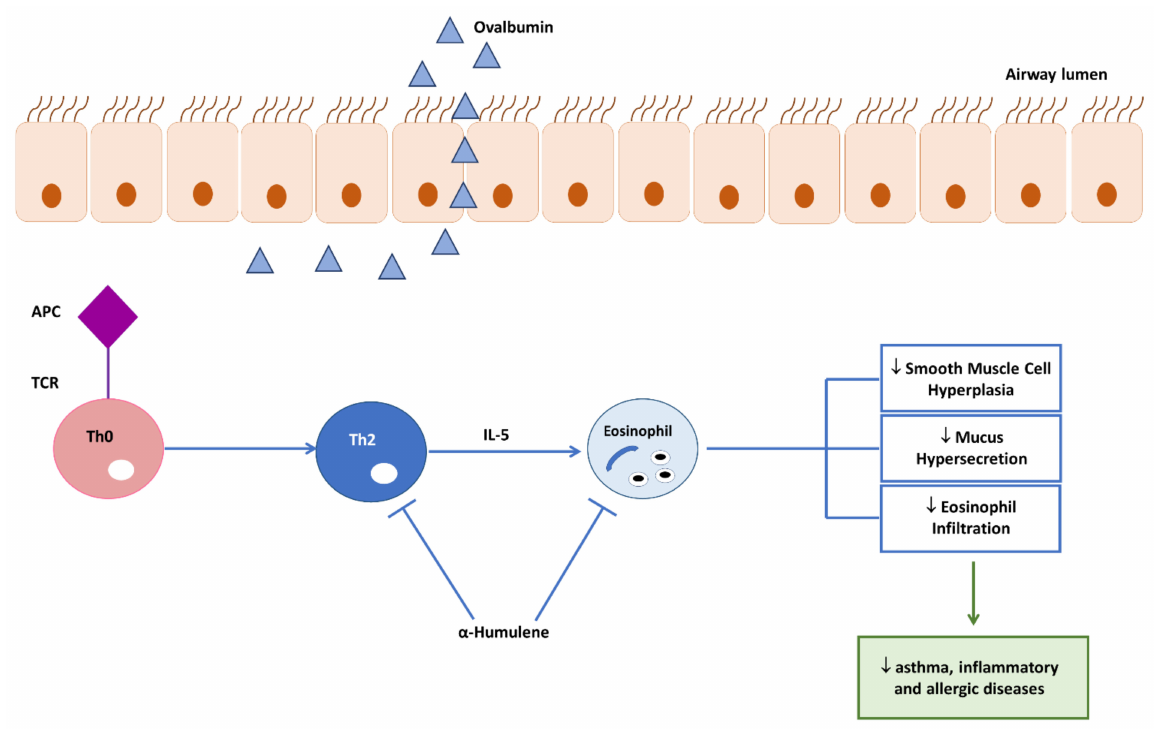
Figure 3. Proposed mechanisms accounting for the modulation of immune response related to allergic diseases by α -humulene. The substance was found to be able to block the Th2-mediated activation of eosinophils, thus reducing the inflammatory response. ↓